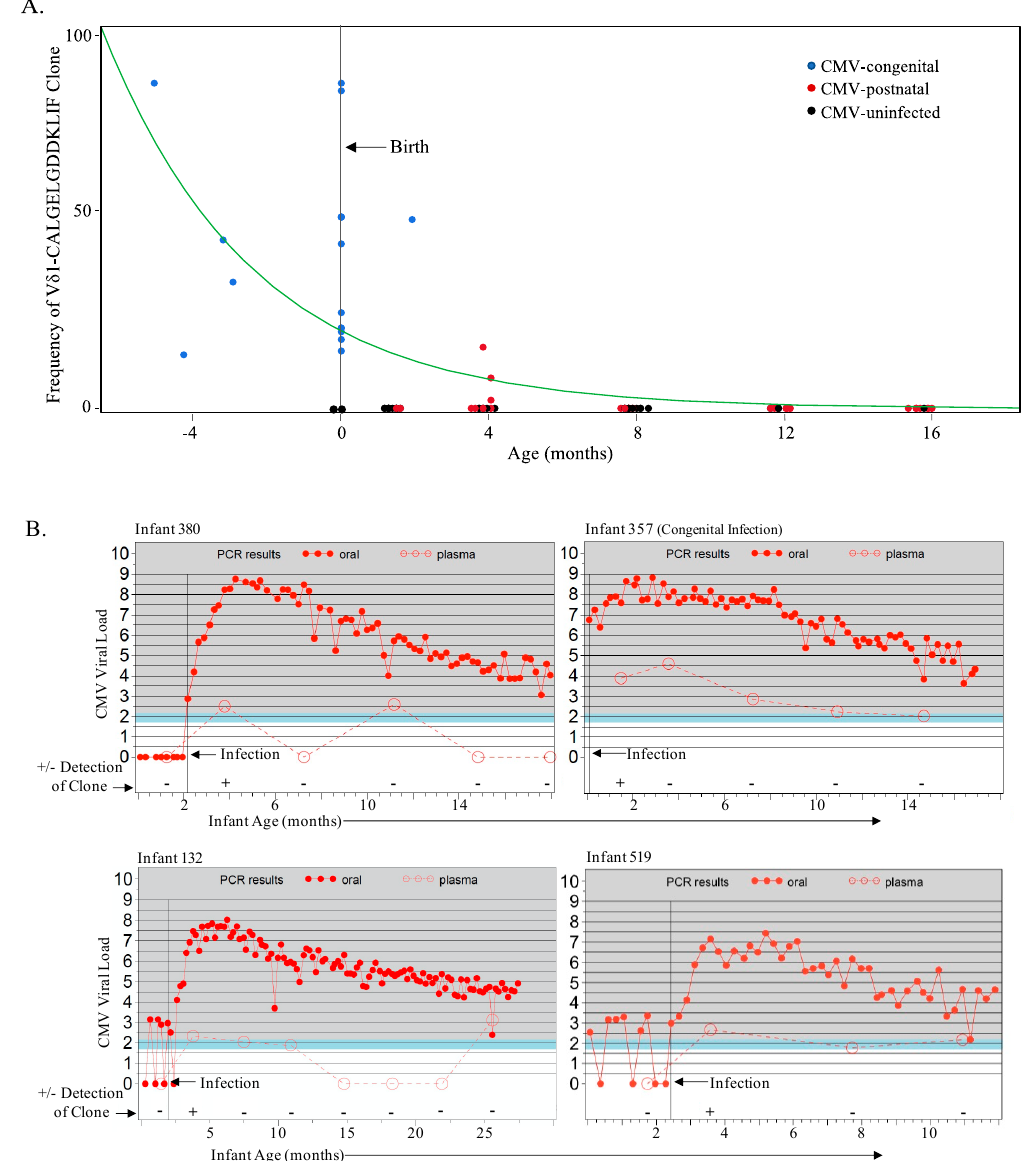
Figure 3. The fetal V δ 1-CALGELGDDKLIF public clone is detected in congenital and early postnatal CMV infection and decays rapidly. ( A ) Frequencies of the public V δ 1-CALGELGDDKLIF clonotype (using HTC and as a proportion of total V δ 1 cells) from the Ugandan infant cohort (17 postnatally infected, 1 congenitally infected and 8 uninfected) sampled starting from 6 weeks of age, as well as 16 Belgian cCMV samples (4 fetal and 12 cord blood) and 2 CMV-uninfected Belgian cord blood samples. Age of zero represents birth and the green spline estimates the rate of decay. Blue data points represent sampling from the congenital infections ( n = 17), red represents samples (time points) from postnatal CMV infections ( n = 33), and black represents samples (time points) from CMV-uninfected samples ( n = 32); ( B ) Graphs represent data from those CMV-infected infants from the Ugandan cohort in whom the V δ 1-CALGELGDDKLIF clonotype was detected. The vertical black line denotes the age of CMV acquisition; the filled red circles indicate the CMV viral load from weekly oral swabs and the open red circles indicate the viral load in plasma as well as the time points at which PBMC were available for TCR sequencing. Every detection of the V δ 1-CALGELGDDKLIF clonotype in postnatal CMV-infected infants was from the time point immediately following infection.